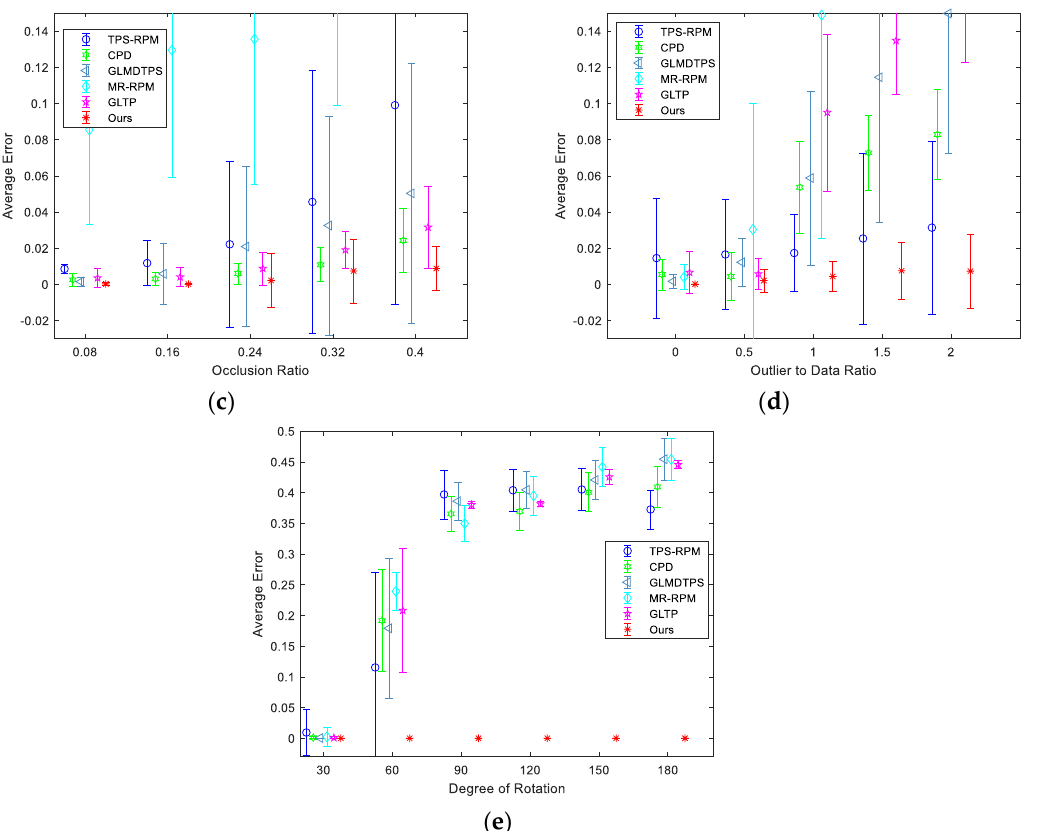
Figure 2. Quantitative comparisons of TPS-RPM, CPD, GLMDTPS, MR-RPM, and GLTP, and the proposed algorithm on fish dataset. ( a – e ) Registration results under degradations of deformation, noise, occlusion, outliers, and rotation, respectively. The error bars indicate the mean and standard deviation of registration errors over 100 trials.